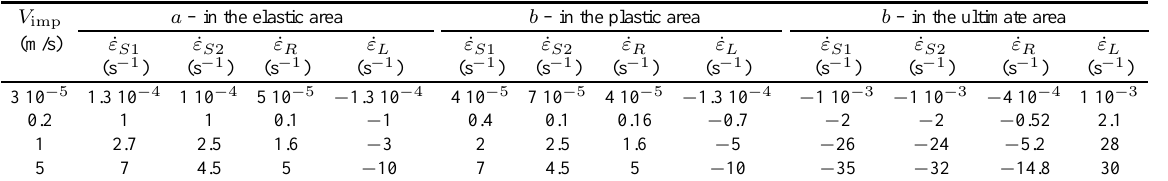
Table 7 Local strain rates of the quasi-static and dynamic shear